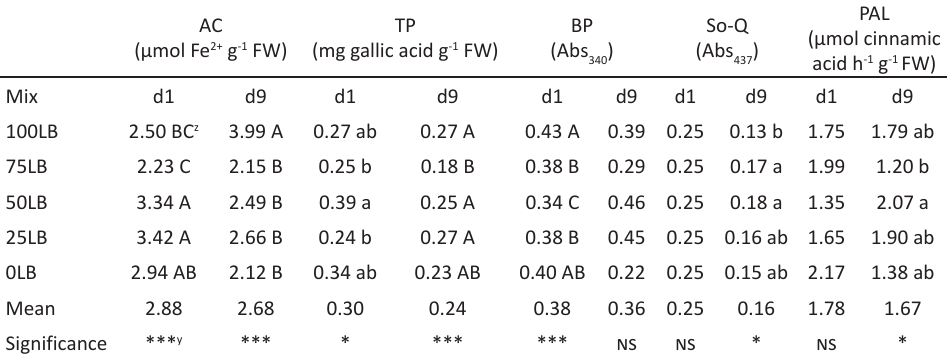
Table 3. Antioxidant capacity (AC), total phenolic (TP) content, browning potential (BP), soluble quinone (So-Q) content and phenylalanine ammonia lyase (PAL) activity in the fresh-cut product (100% ‘Lollo Bionda’